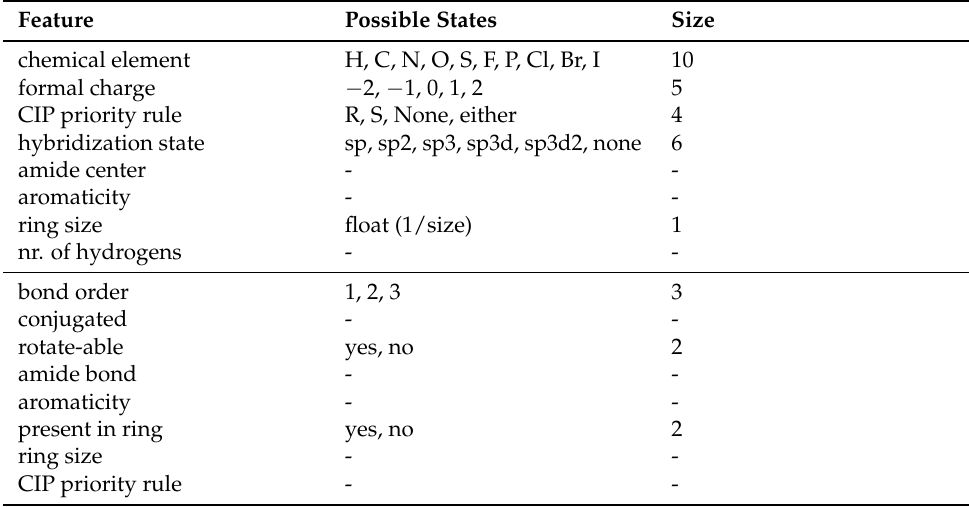
Table A6. Node and edge featurization of type 8. Each node or edge featurization vector consisted of a concatenation of the different one-hot encoded or floating point feature vectors according to their possible states (if present) and corresponding size-26 for nodes and 7 for edges.